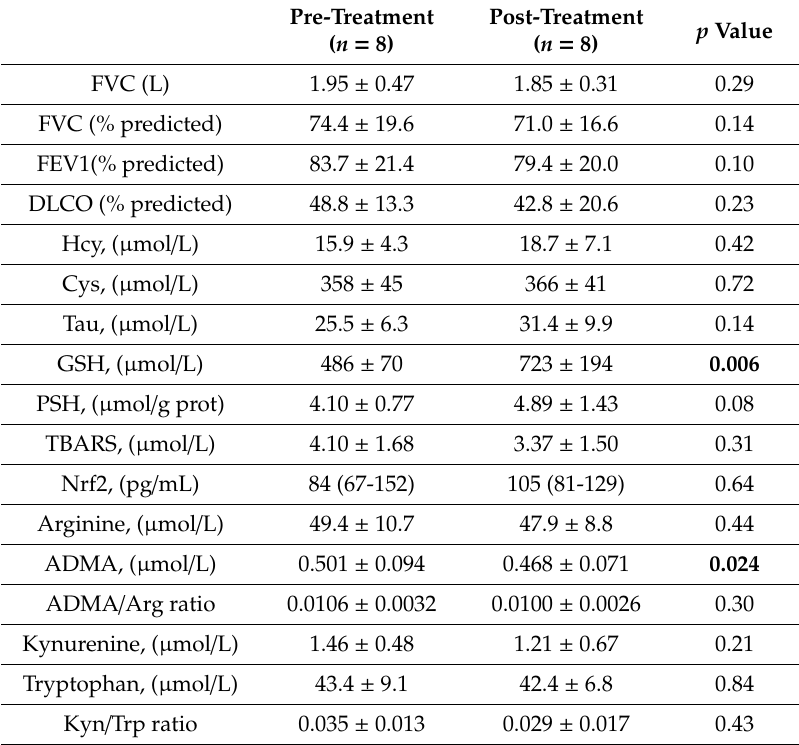
Table 4. Clinical and laboratory characteristics of IPF patients at baseline and after 24 weeks of Nintedanib